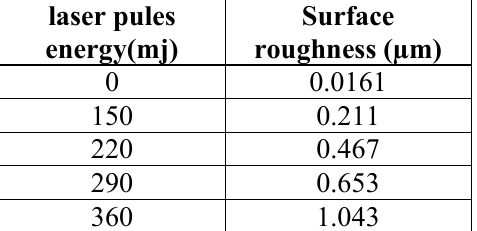
Table 4: Relation between laser